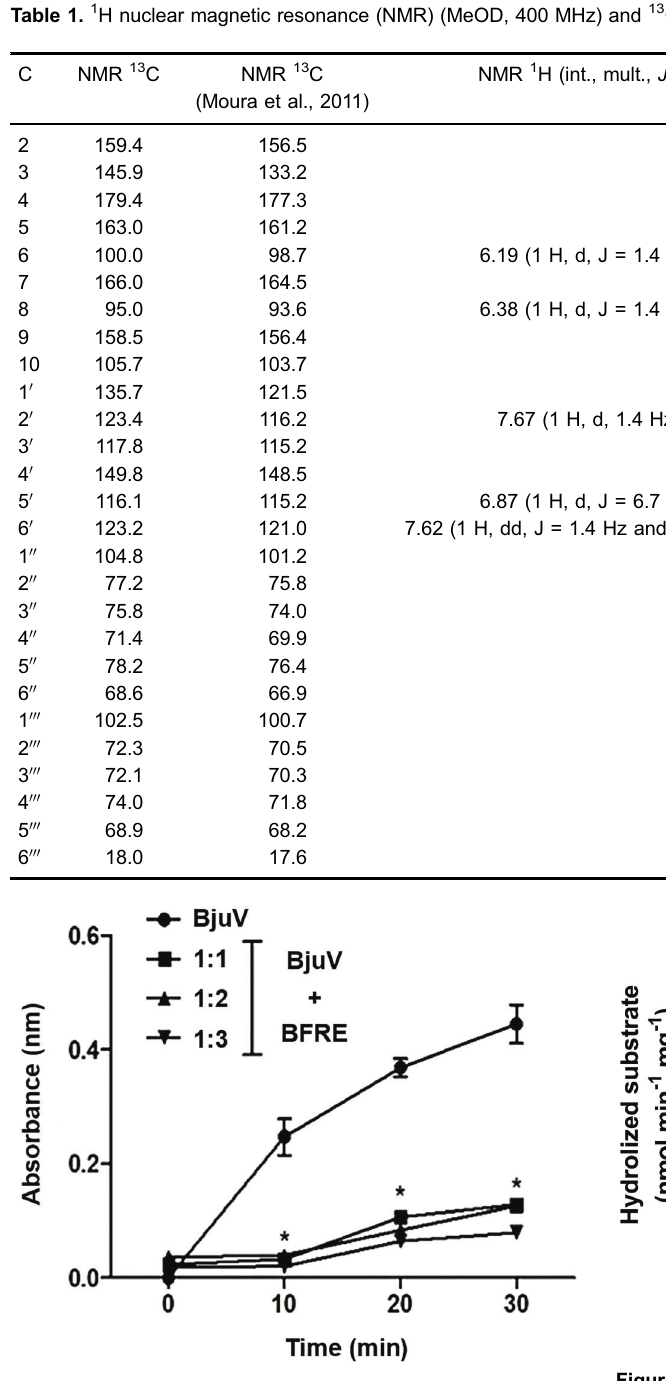
Figure 1. Effect of Bredemeyera fl oribunda root extract (BFRE) on the phospholipase A2 activity of Bothrops jararacussu venom (BjuV). BFRE was preincubated with BjuVat ratios of 1:1, 1:2, and 1:3 (BjuV:BFRE). 4N3OBA was used as a substrate and increasing absorbance was measured at 425 nm. Data are reported as means ± SE. *P o 0.05 compared to BjuV (ANOVA with Bonferroni post-test).